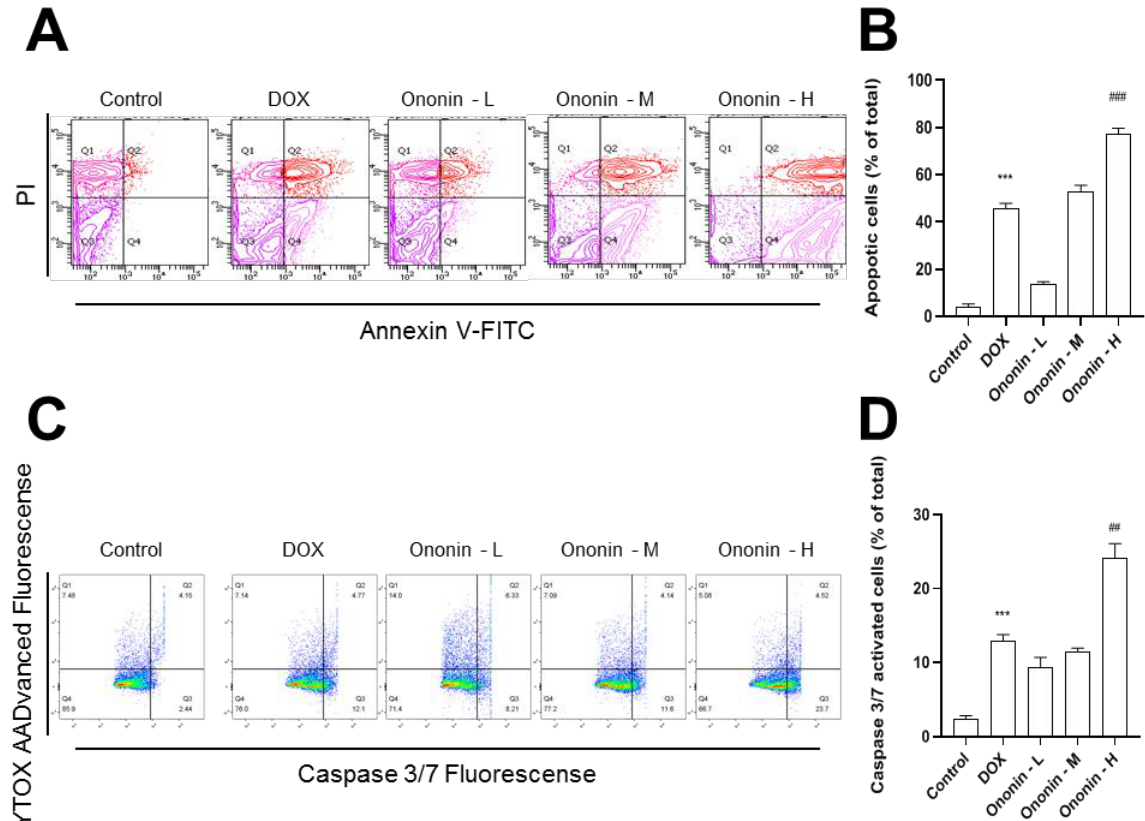
Figure 8. The homogenized tumor tissue was subjected to the flow cytometer for analyzing the anti-osteosarcoma cell proliferation properties. ( A ) The viable cell population was displayed in the bottom left quadrant (Q3), the early apoptotic cells in the bottom right quadrant (Q4), and the late apoptotic cells in the top right quadrant (Q4) of the dual parametric dot plots integrating annexin V-FITC and PI fluorescence (Q2). ( B ) The quantification analysis was conducted by the program Flowjo v7.6. ( C ) The dual parametric dot plots combining caspase 3/7 and SYTOX AADvanced fluorescence showed activated caspase 3/7 in the bottom right quadrant (Q4). ( D ) The quantification analysis was conducted by the program Flowjo v7.6. The values are expressed as the percentage of total cell number, n = 6, in Mean ± SEM. Ononin at 1, 3, and 10 mg/kg/i.p were shown as -L, -M, and -H, respectively. *** p < 0.001 was considered a significant result when compared to control, and ## p < 0.01 or ### p < 0.001 were considered significant results when compared to DOX group.